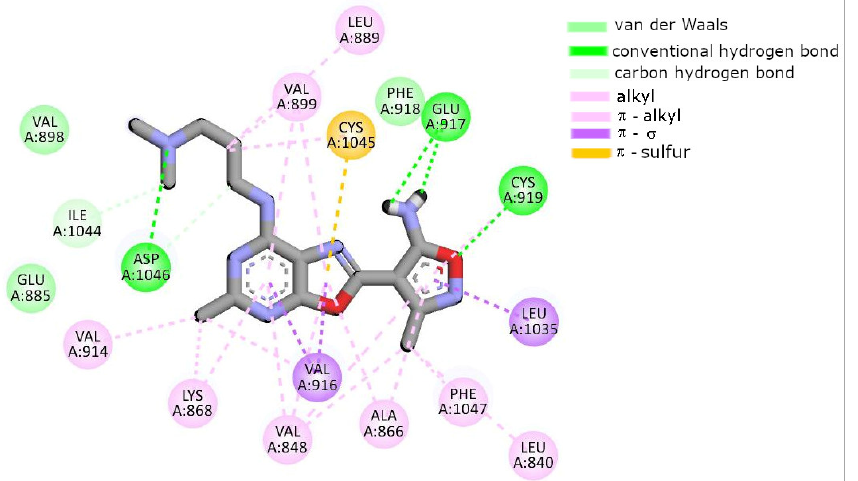
Figure 9. The comparison of the intermolecular interactions of the drug tivozanib, compound 3g , and the 5-methyl analog of compound 3g ( SCM9 ) (shown from top to bottom, respectively) with the active center of VEGFR-2.